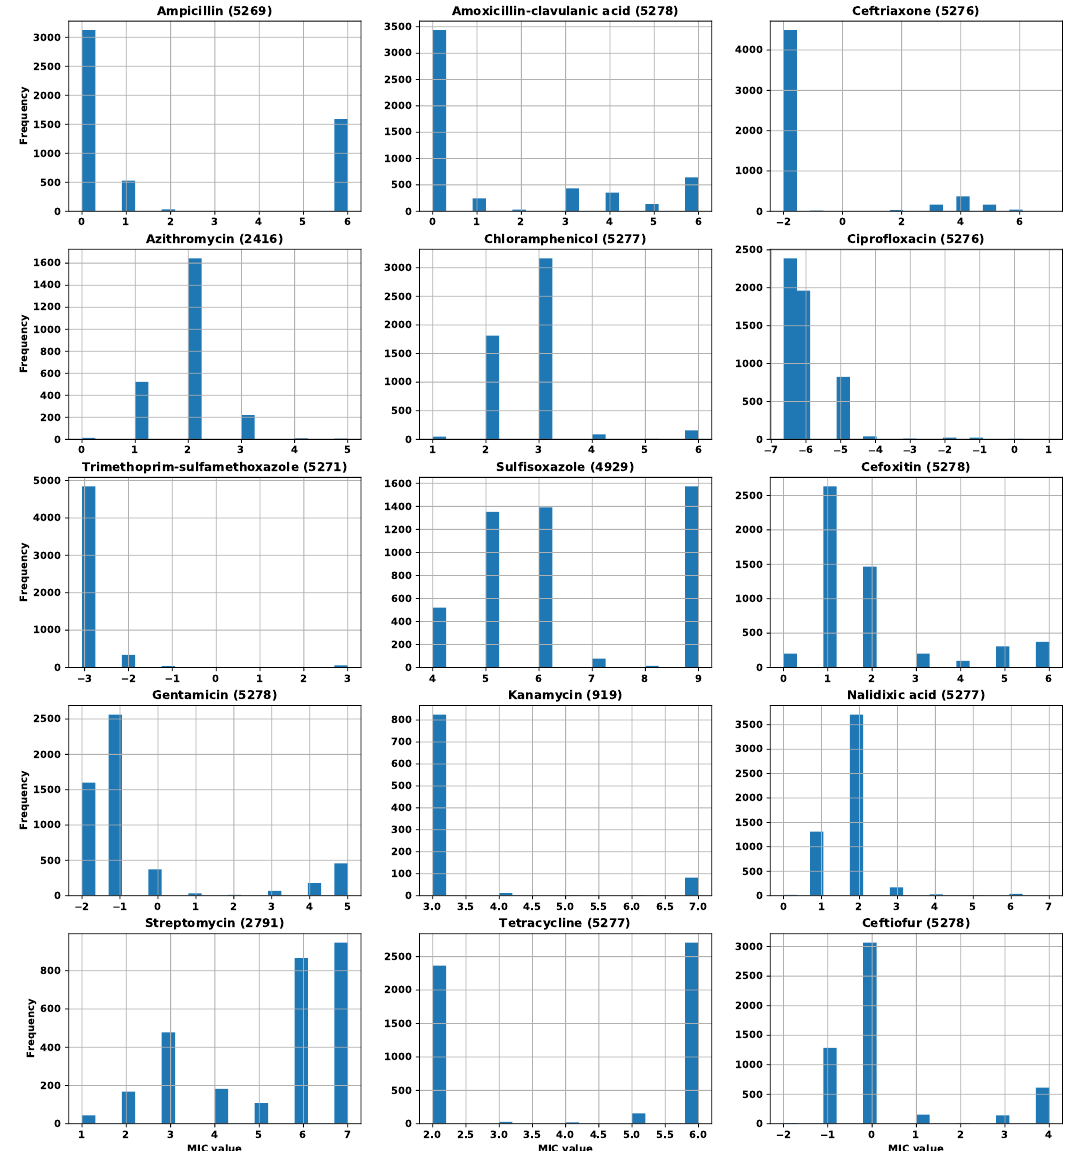
Figure A4. Distribution of S. enterica MIC values for different antibiotics. These are the values after processing and conversion to log 2 scale. The antibiotic’s name is printed on the title of each sub-figure. The number of genomes is presented in